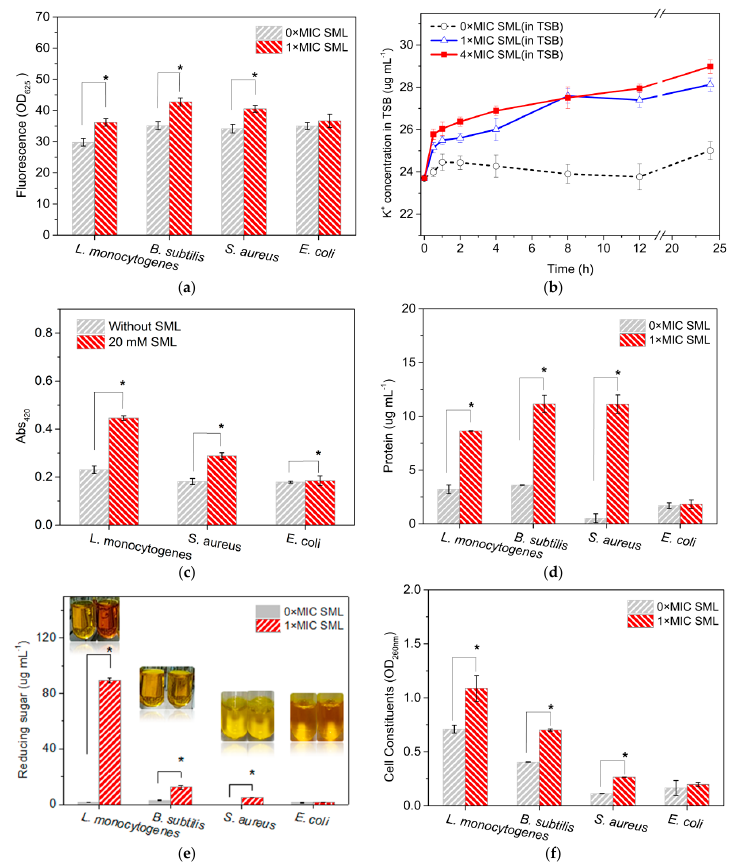
Figure 2. ( a ) Uptake of propidium iodide of various microorganisms after SML treatment. Effect of SML on cell constituents’ release of various bacteria; ( b ) Potassium ion efflux of L. monocytogenes cell suspensions in TSB; ( c ) Absorbance of o -nitrophenol (ONP) at 420 nm (Abs 420 ) from the supernatants of different cells with 20 mM SML treatment; ( d ) Protein. The error bars represent the standard deviations, and the asterisks indicate significant difference between each other; ( e ) UV-absorbing substances leaking (OD 260 nm); ( f ) Reducing sugar. The error bars represent the standard deviations, and the asterisks indicate significant difference between each other.